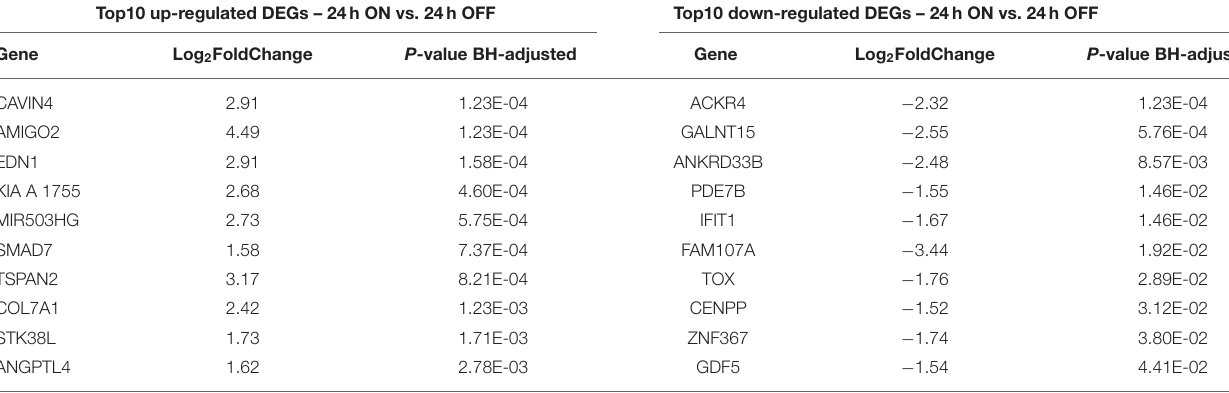
TABLE 3 | DEGs consistently regulated by mechanical stress. Gene Gene ID Function